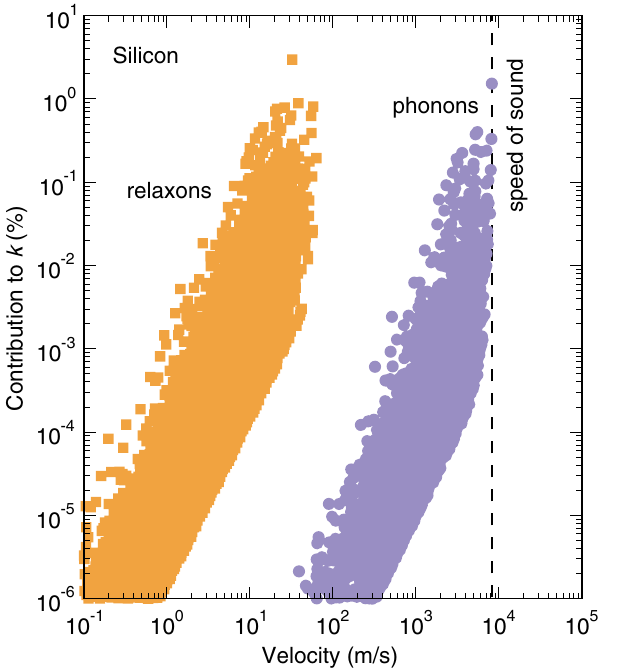
FIG. 8. Analysis of phonon and relaxon mean free paths and their contributions to the thermal conductivity of silicon at room temperature. The difference between velocities is carried over to this spectrum, so relaxon mean free paths are shifted to smaller values with respect to phonons. While our estimates of mean free paths for phonons extend up to hundreds of micrometers, relaxon mean free paths barely reach the micrometer